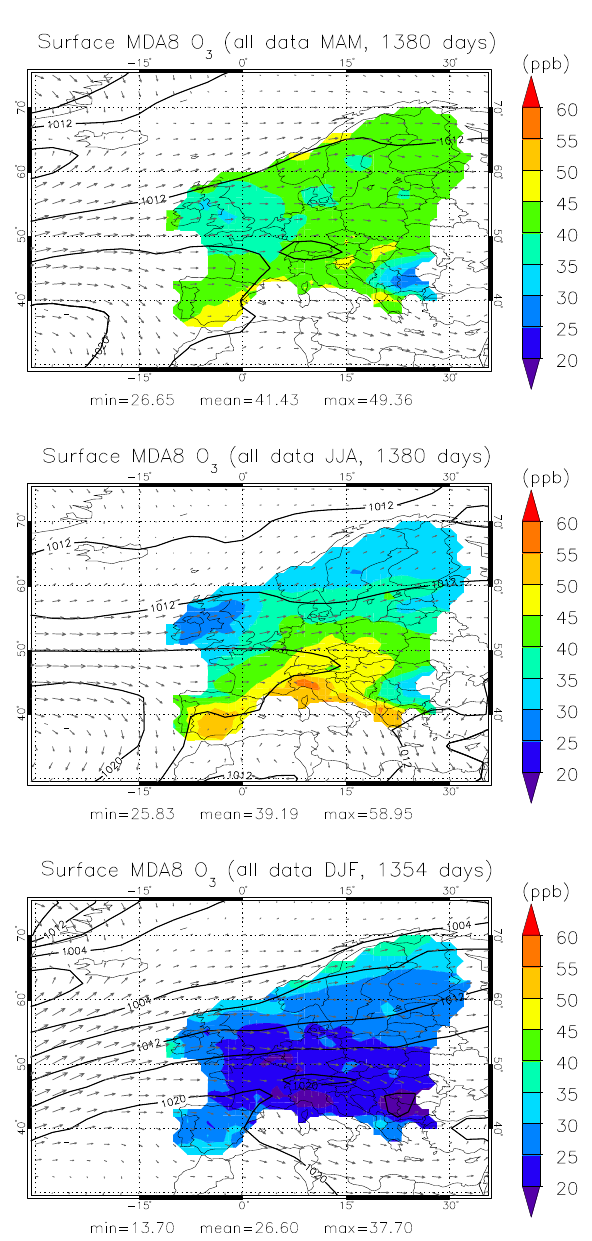
Figure 1. Composites of the seasonal means of maximum daily 8h running average near-surface ozone (MDA8 O 3 ) expressed in parts per billion by volume (ppb, shaded areas) in spring (top), summer (middle) and winter (bottom) during the 1998–2012 period. The black contour lines depict the mean sea level pressure (MSLP) for the same period, expressed inhPa. Arrows indicate horizontal winds at 850hPa. The total number of days considered is indicated on the top of each